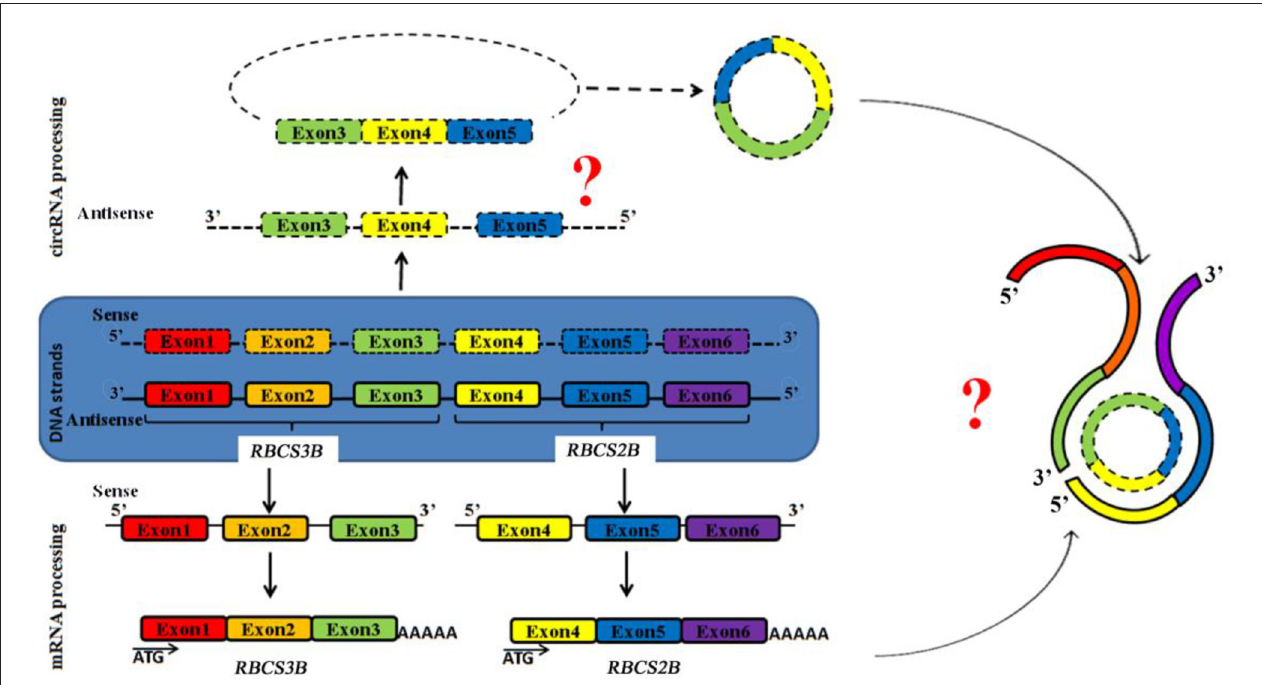
FIGURE 4 | Schematic model to show the expression of both strands of genomic DNA of RBCS3B and RBCS2B genes. Square frames exhibit the exon regions. Two question marks indicate two critical steps: edition of antisense RNA and function of this antisense circRNA.